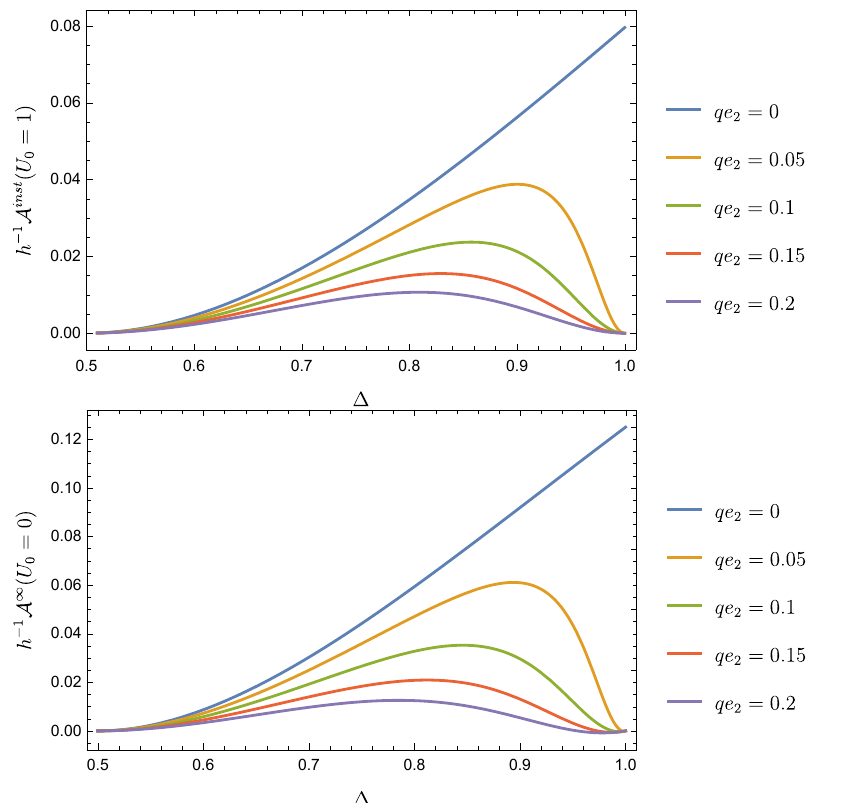
Figure 5 . The ANE as a function of ∆ . For q > 0 , the ANE is suppressed at ∆ = 1 by the factor of sin( π ∆) in C ∆